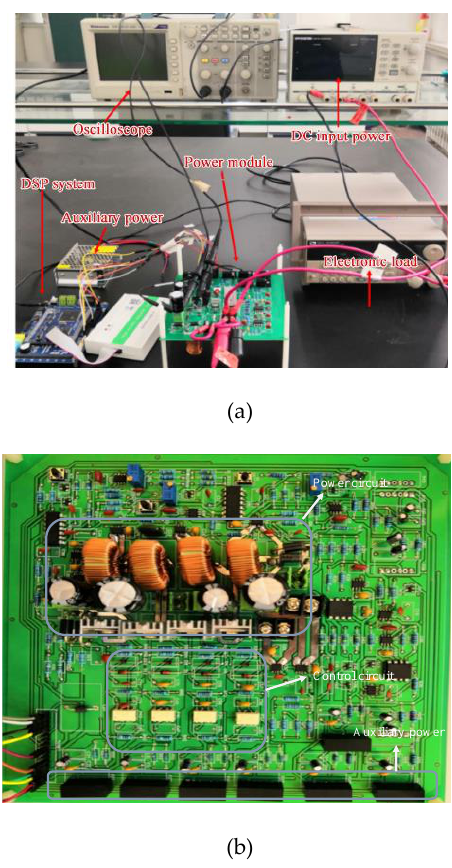
Figure 14. The prototype of proposed converter. ( a ) The experimental platform of double-boost converter. ( b ) Experimental prototype of four-phase interleaved DC/DC converter.